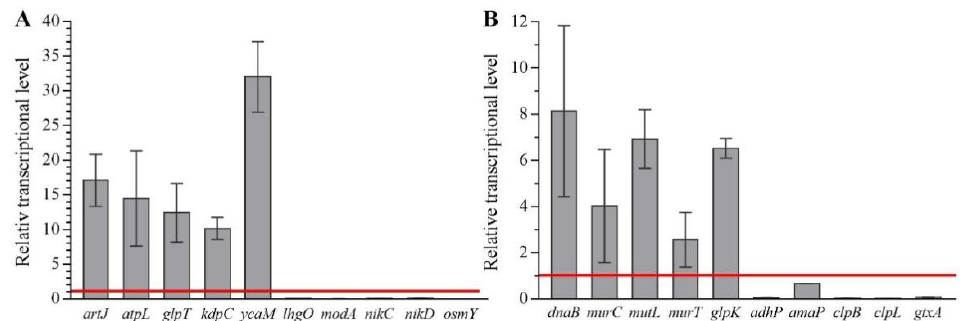
Figure 5. Fold change of selected genes by qRT-PCR after bacterial cells were treated with CFS from L. rhamnosus SCB0119 in E. coli ATCC25922 ( A ) and S. aureus ATCC6538 ( B ). The bacterial 16S rRNA was used as an internal standard. The red line at value 1 represented the expression of chosen genes in the control groups. Error bars: SD of the mean from three repeated